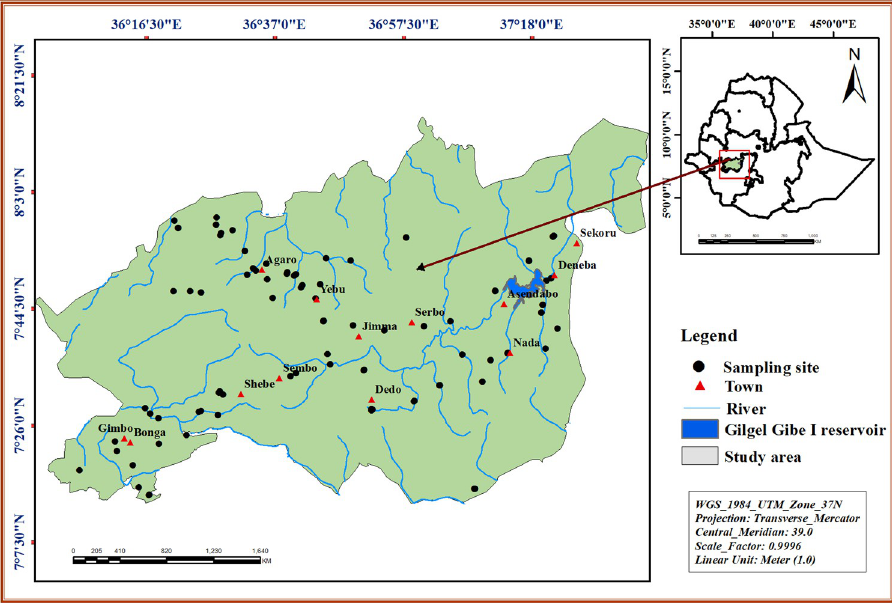
Fig 1. Map of the study area and locations of the sampling sites in the Omo Gibe river basin, southwest Ethiopia.